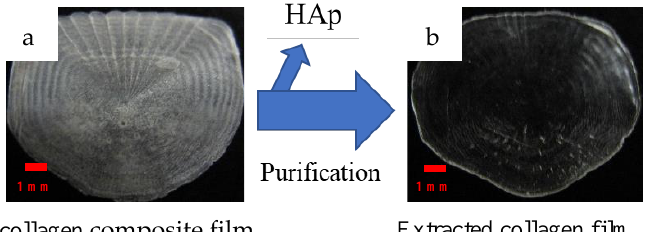
Figure 1. Hap-collagen composite film and collagen film. ( a ) HAp-collagen composite film from fish. HAp-collagen composite film from fish. ( b ) Purified collagen film.